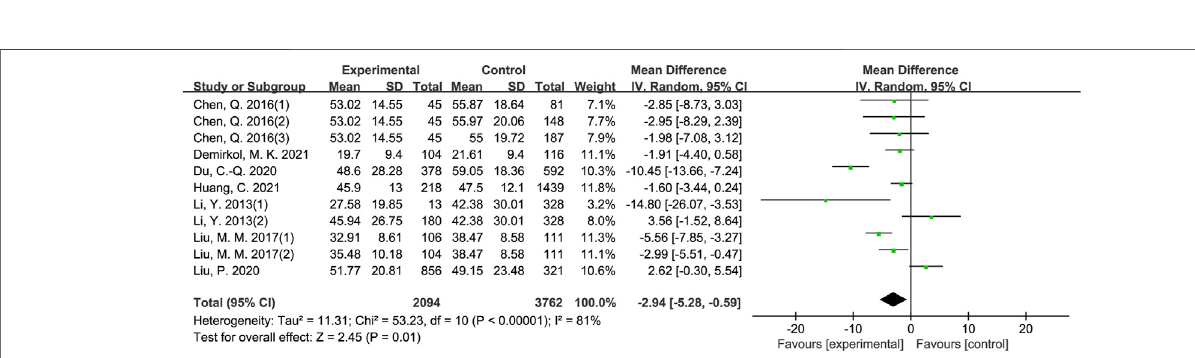
FIGURE 3 | Forest map evaluating the effects of sleep disorders on sperm concentration.